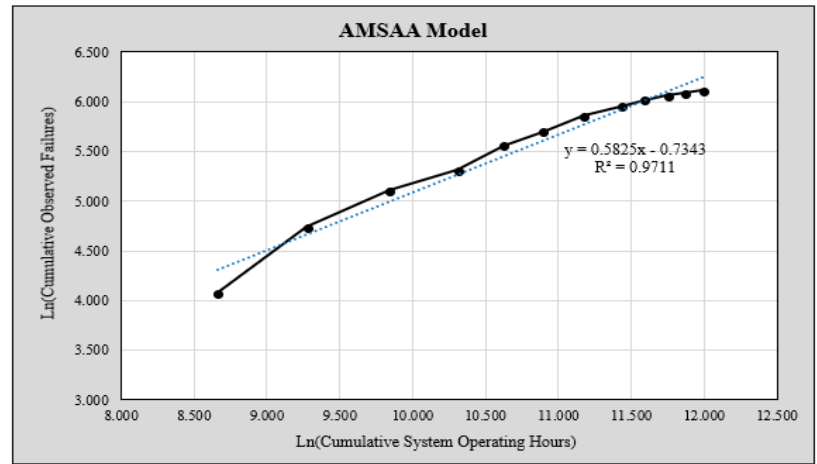
Figure 3. Plot of ln (Cumulative Observed failures) vs. ln (Cumulative system operating hours)